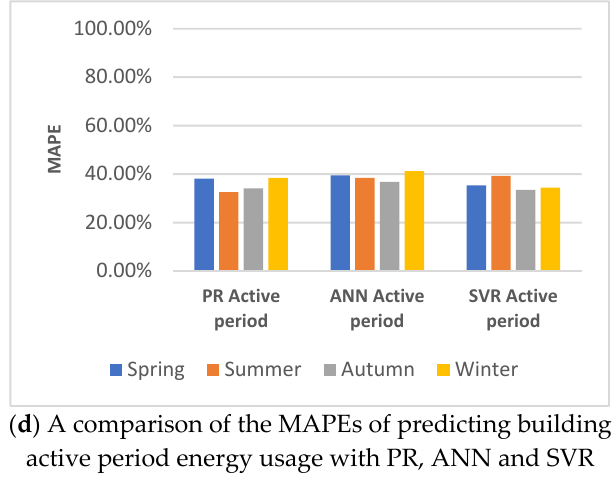
( c ) A comparison of the MAPEs of predicting building